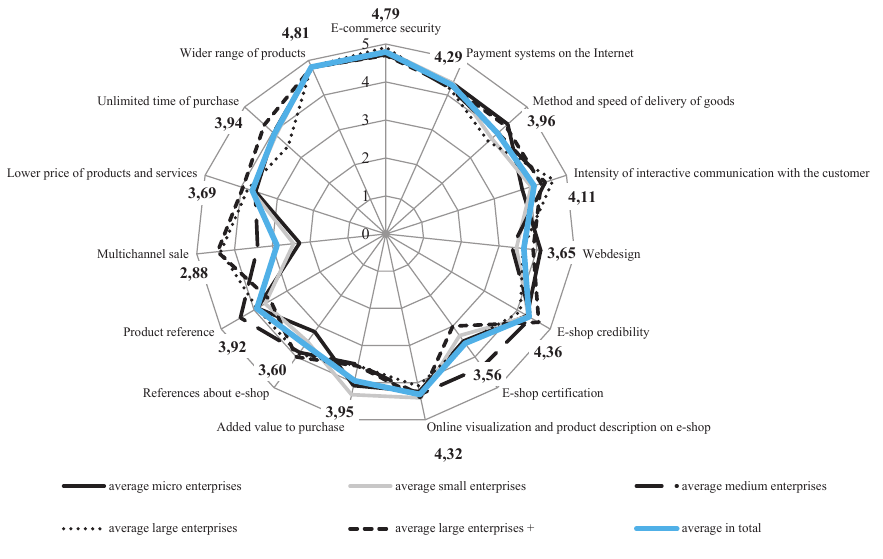
Fig. 1 – Average quality evaluation of determinants of online shopping behavior by enterprise size. Source: own